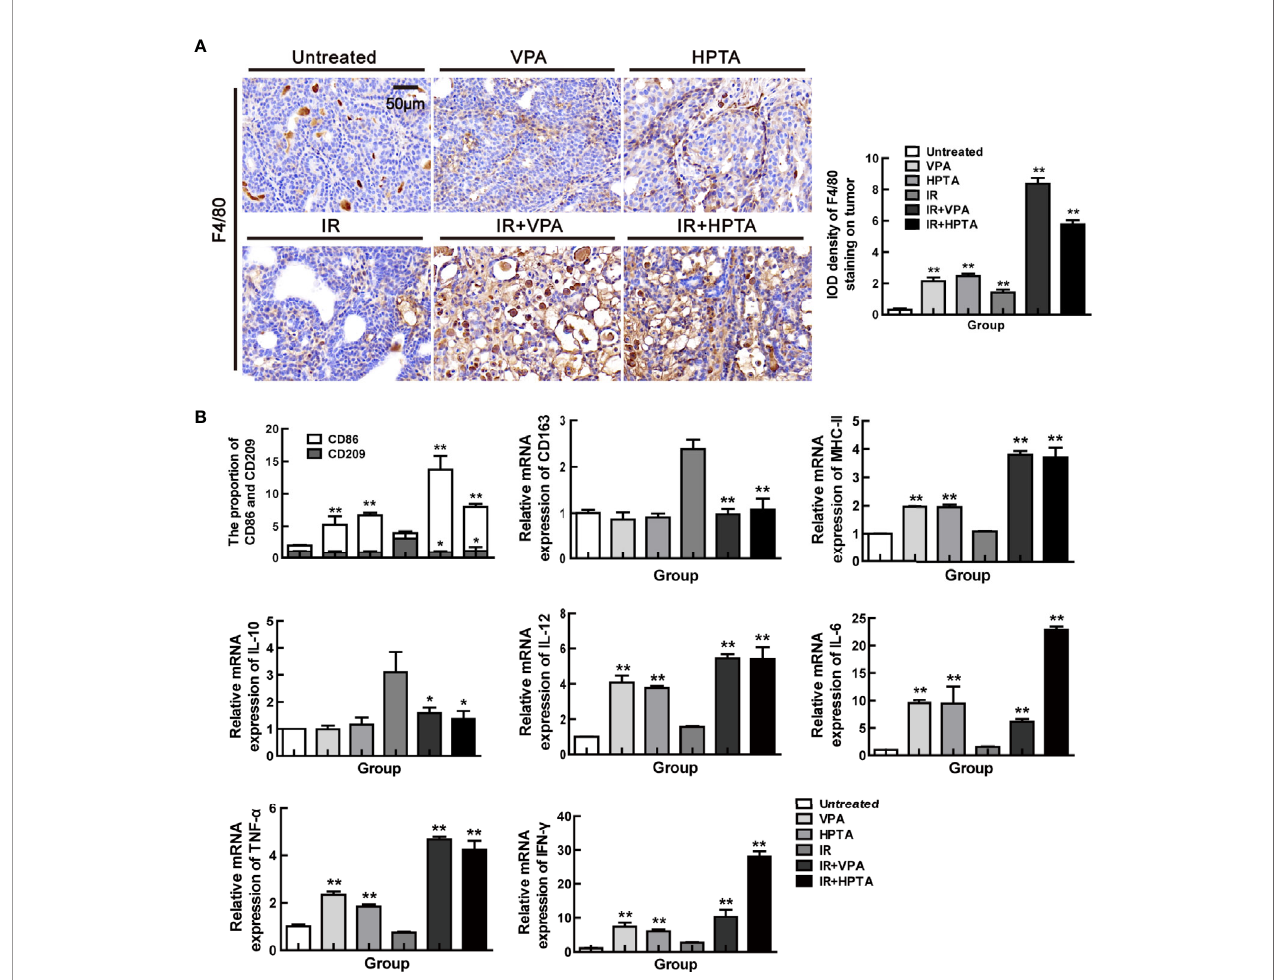
FIGURE 2 | VPA/HPTA activates the macrophages and reprograms TAMs polarization towards M1 phenotype in irradiated breast tumor at the early stage of the treatment (A) IHC was performed on tumor sections with the macrophage-speci fi c marker F4/80 to assess in fi ltration of macrophages, and representative quantitation and images are shown. (B) The mRNA expression levels of CD86, CD209, CD163, MHC-II, IL-10, TNF- a , IFN- g , IL-6 and IL-12 in DMBA-induced breast tumors in rats were determined by real-time PCR. Data were normalized to untreated group. Each data point in the graphs was from three independent experiments (mean ± SD). P -values were calculated by Student ’ s t-test (* P < 0.05, ** P <